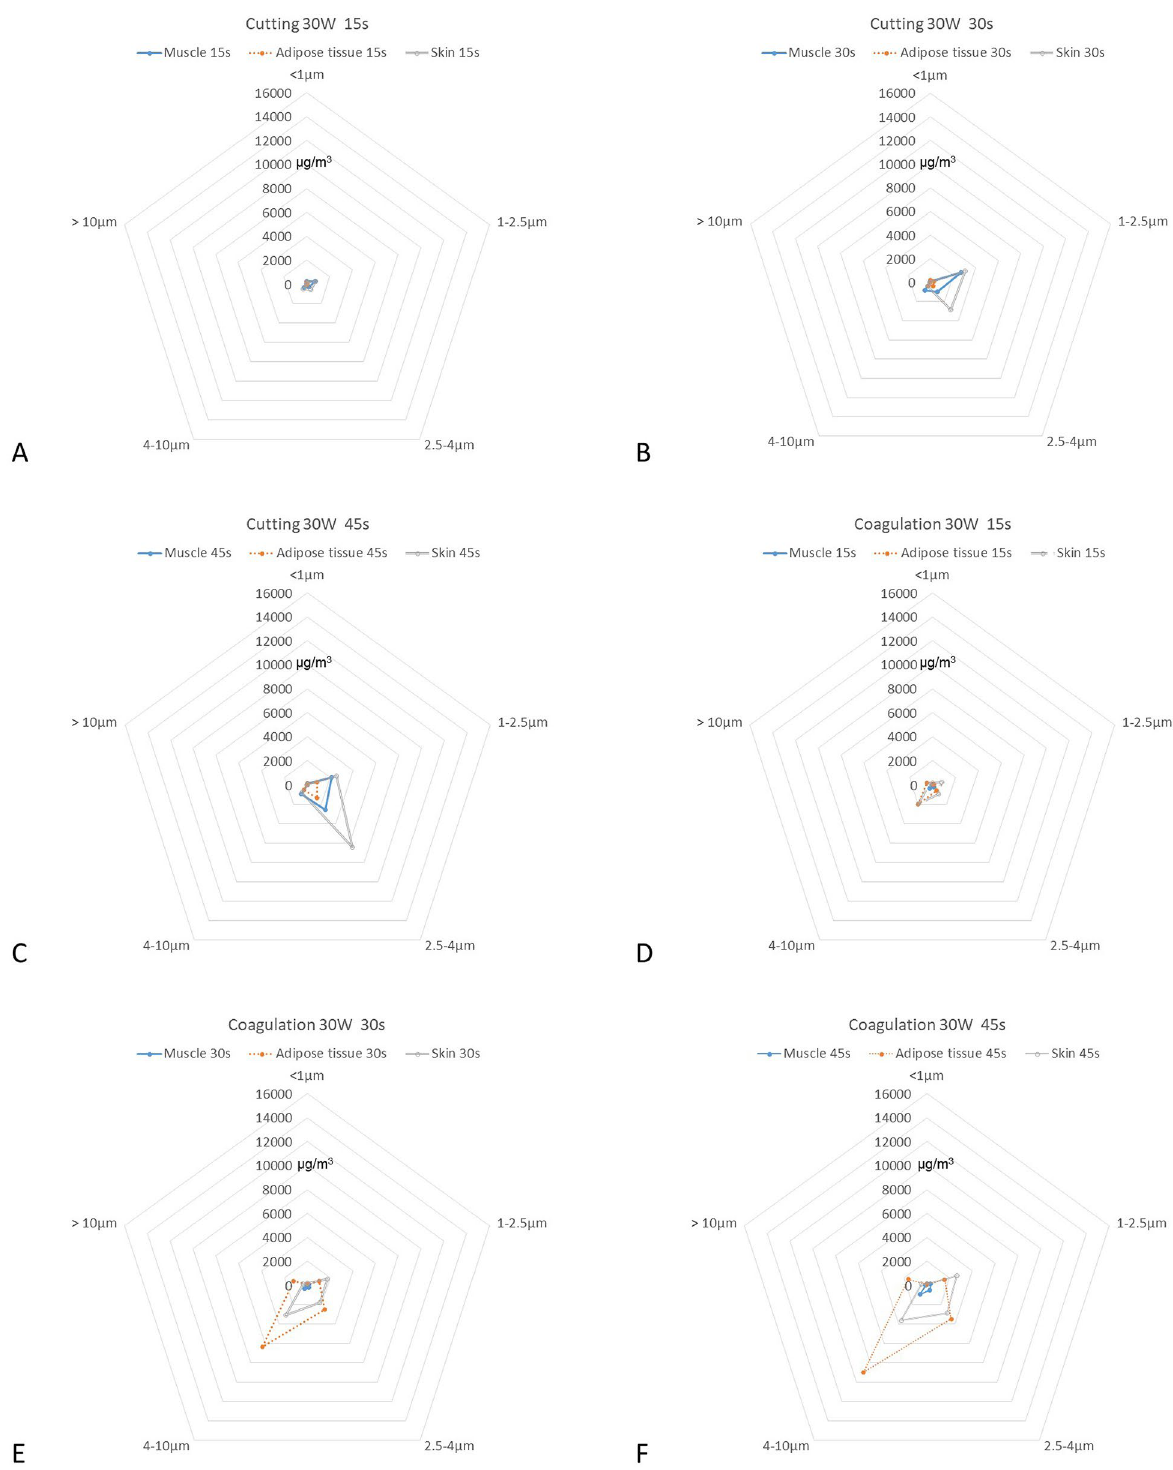
Figure 3. The concentration of different types of particulate matter among different tissues in porcine model with cutting ( A – C ) and coagulation ( D – F ) modes. The measured average smoke concentration increased gradually with time. Skin tissue in cutting mode and adipose tissue in coagulation mode would produce higher smoke